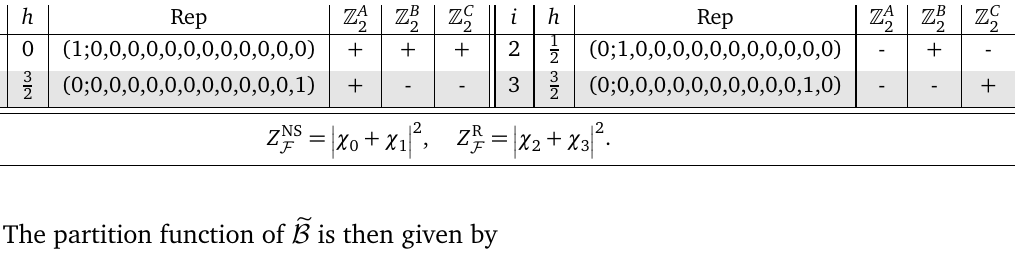
Table 17: SO ( 24 ) : primaries labeled by i are characterized by weights h and SO ( 24 ) Dynkin la- 1 bels. Their characters are denoted by χ respectively. We highlight the primary related to the (cid:90) The partition functions for F in the NS and R sectors are also presented.